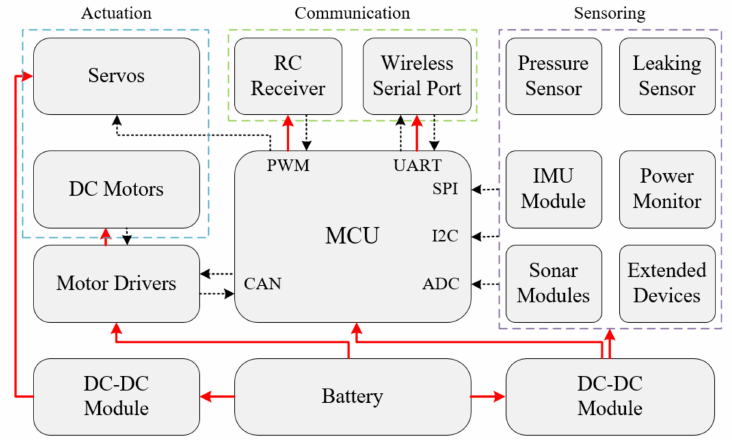
Figure 7. Control system of the biomimetic robot